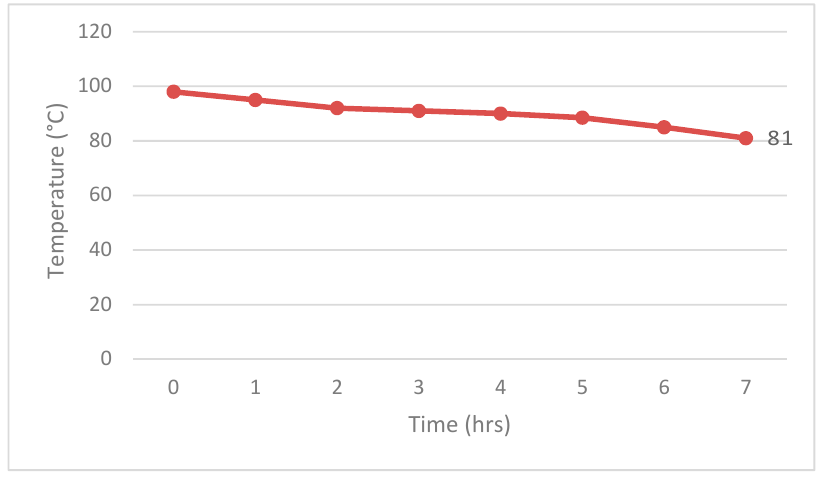
Figure 13. Plot of temperature vs. storage time.